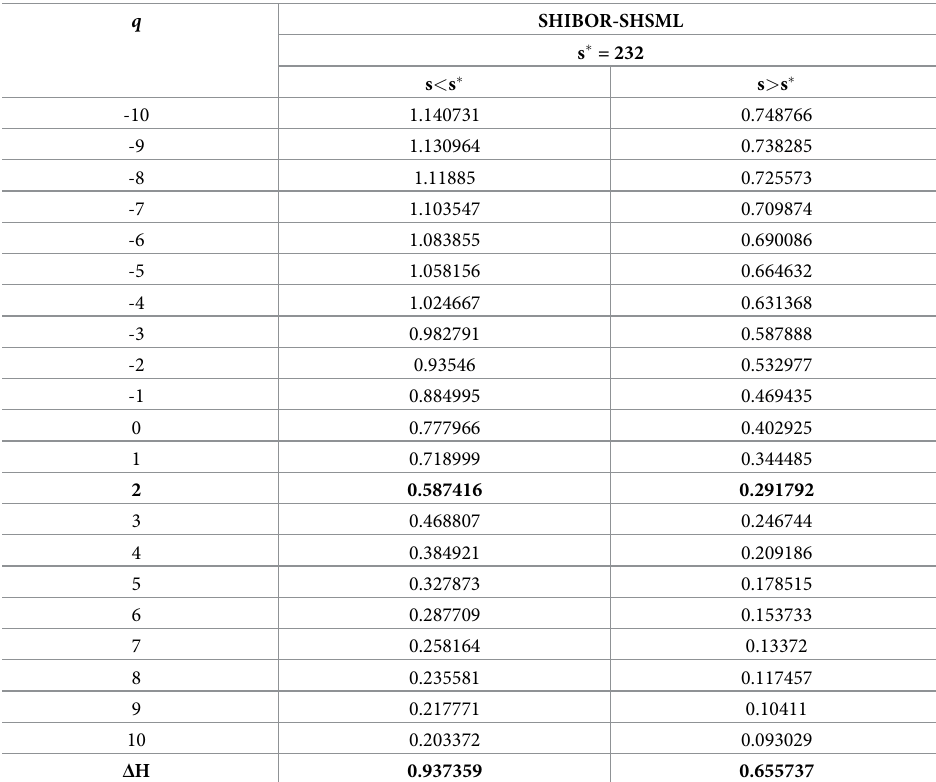
Table 3. The cross-correlation exponent between SHIBOR and